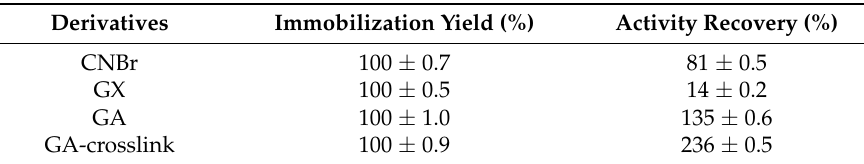
Table 1. Immobilization on covalent supports.